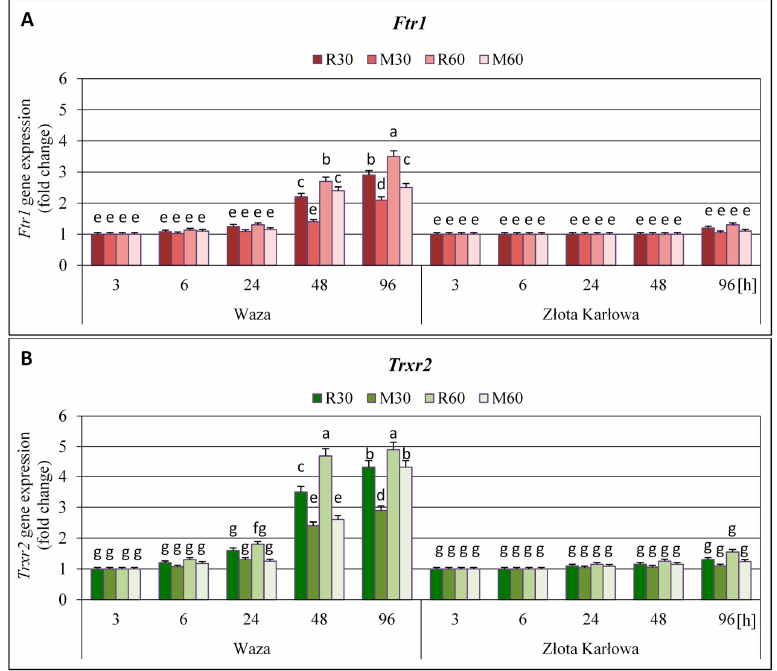
Figure 3. Influence of the cereal aphid infestation on relative expression of Ftr1 ( A ) and Trxr2 ( B ) genes in the leaves of maize seedlings (Waza and Złota Karłowa cvs). R30, R60—maize seedlings of a given cultivar infested with 30 and 60 R. padi females per plant, respectively; M30, M60—maize seedlings of a given cultivar infested with 30 or 60 M. dirhodum females per plant, respectively. Results represent n-fold changes in expression of the examined genes in the aphid-stressed maize seedlings, compared to the non-infested controls. Data were derived from three independent experiments (mean ± SD). Different letters (a, b, c, d, e, f, g) above error bars indicate significant differences between the expression level of the studied genes ( p < 0.05; post-hoc Tukey’s test).